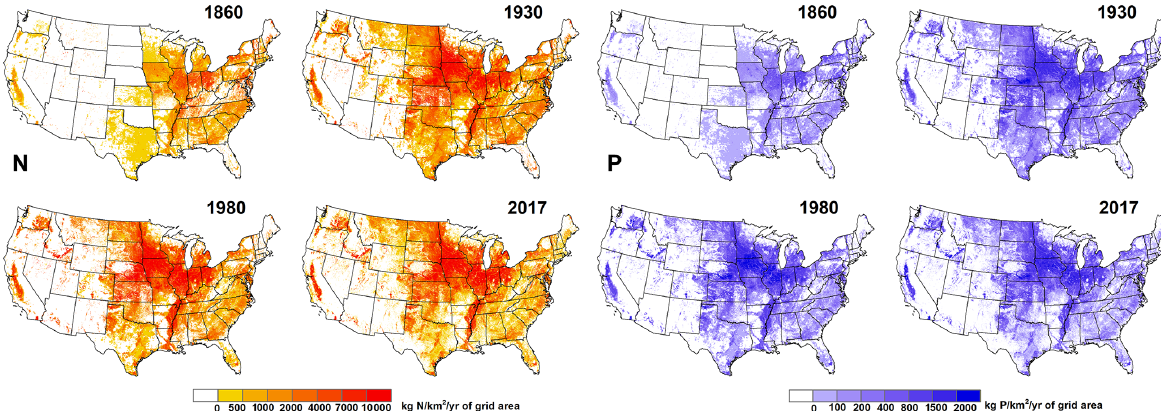
Figure 5. Spatial distribution of N and P demand of crops in 1860, 1930, 1980, and 2017.